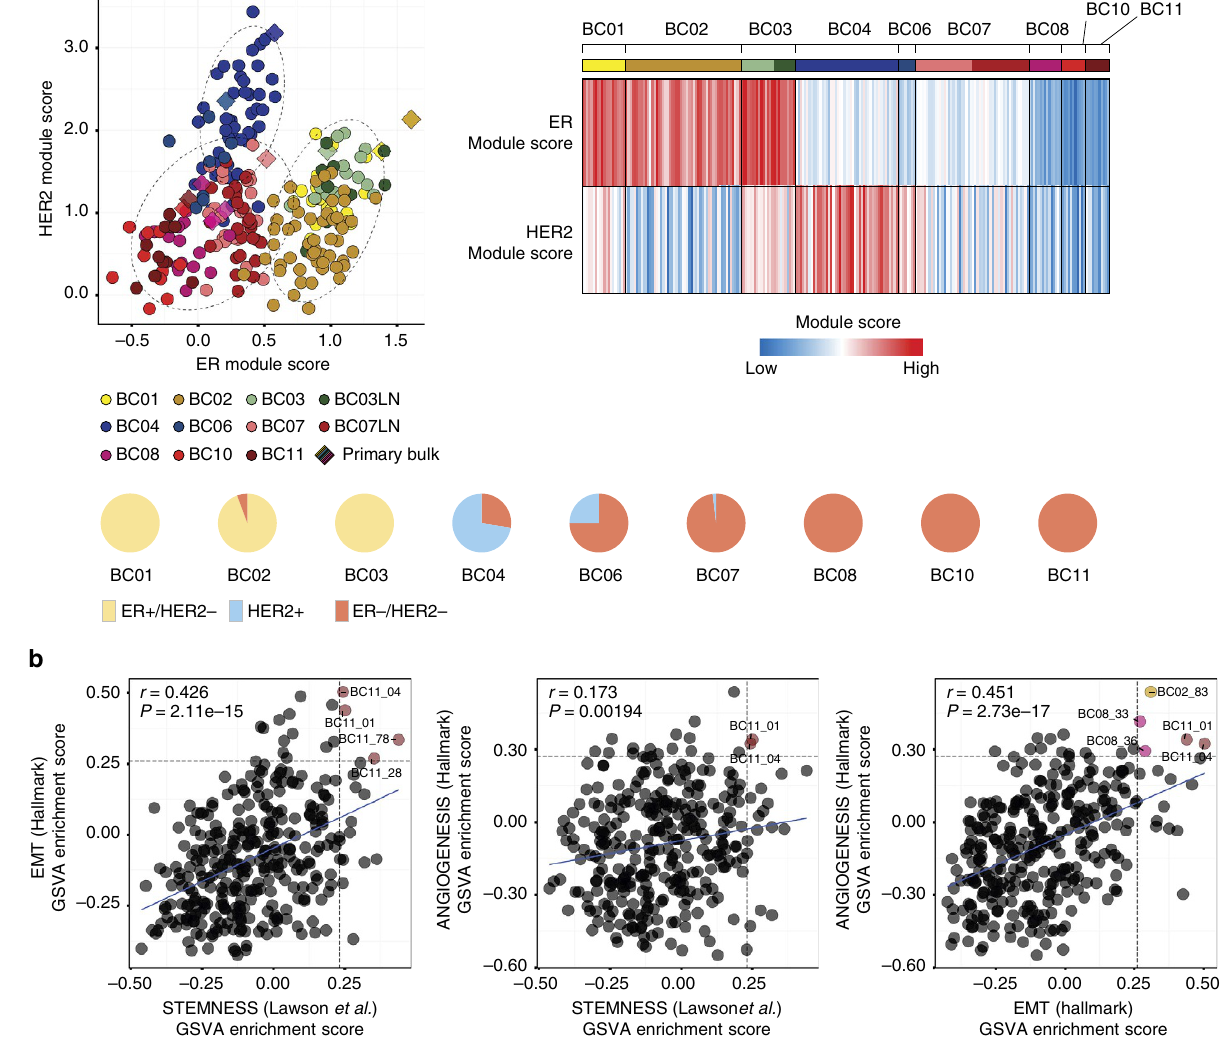
Figure 4 | Intrinsic tumour cell heterogeneity. ( a ) Subtype prediction of tumour cells as ER þ , HER2 þ or TNBC types using ER and HER2 module scores 50 (R software package genefu, top left panel). Heatmap of subtype-specifying module scores (top right) and pie charts (bottom) demonstrating Intratumoral subtype heterogeneity in HER2 tumours. ( b ) Pearson’s correlation coefficient ( r ) between aggressive cancer gene expression signatures (EMT, stemness and angiogenesis). Horizontal and vertical dashed lines indicate signature score cut-offs at top 5%. The linear regression result is drawn as a solid line. The coloured dots mark cells with high expression signatures for both